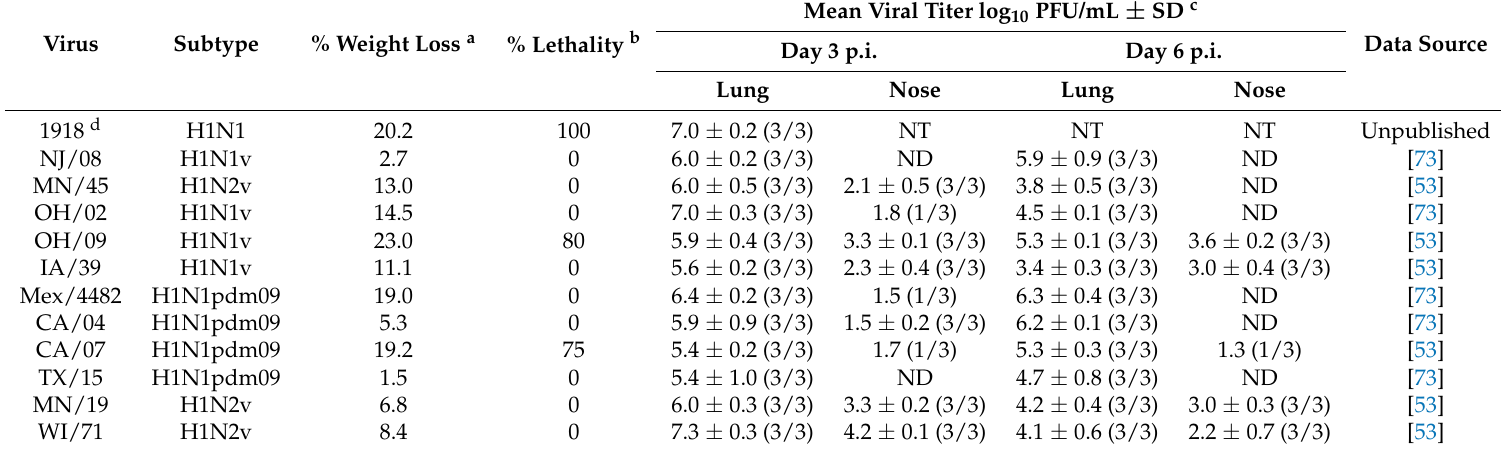
Table 3. Pathogenicity of H1 influenza viruses in